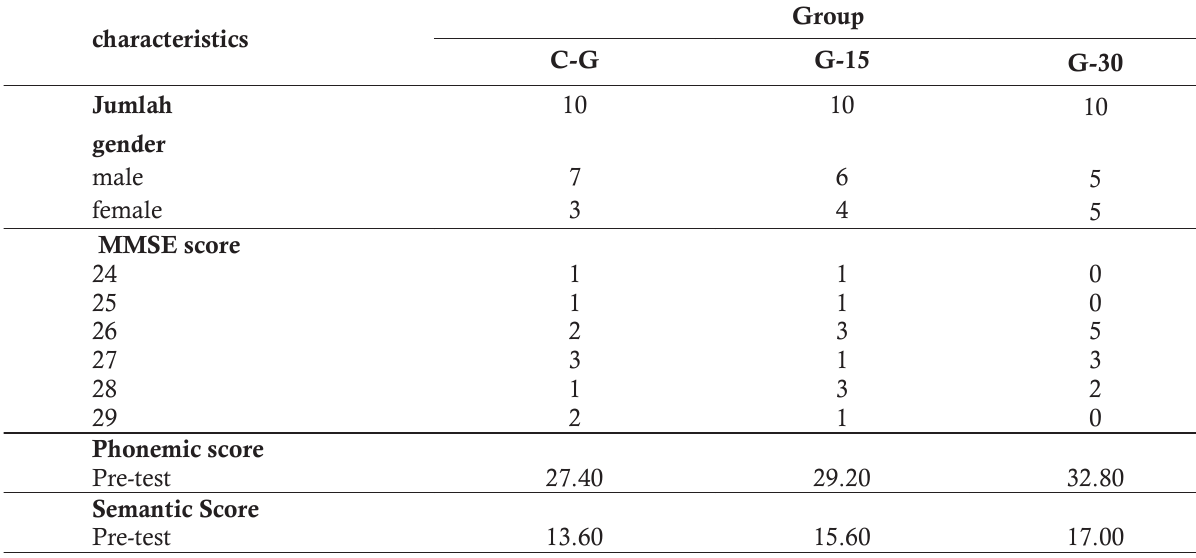
Tabel 2. Mean phonemic and semantic scores of the participants after the reading activity intervention